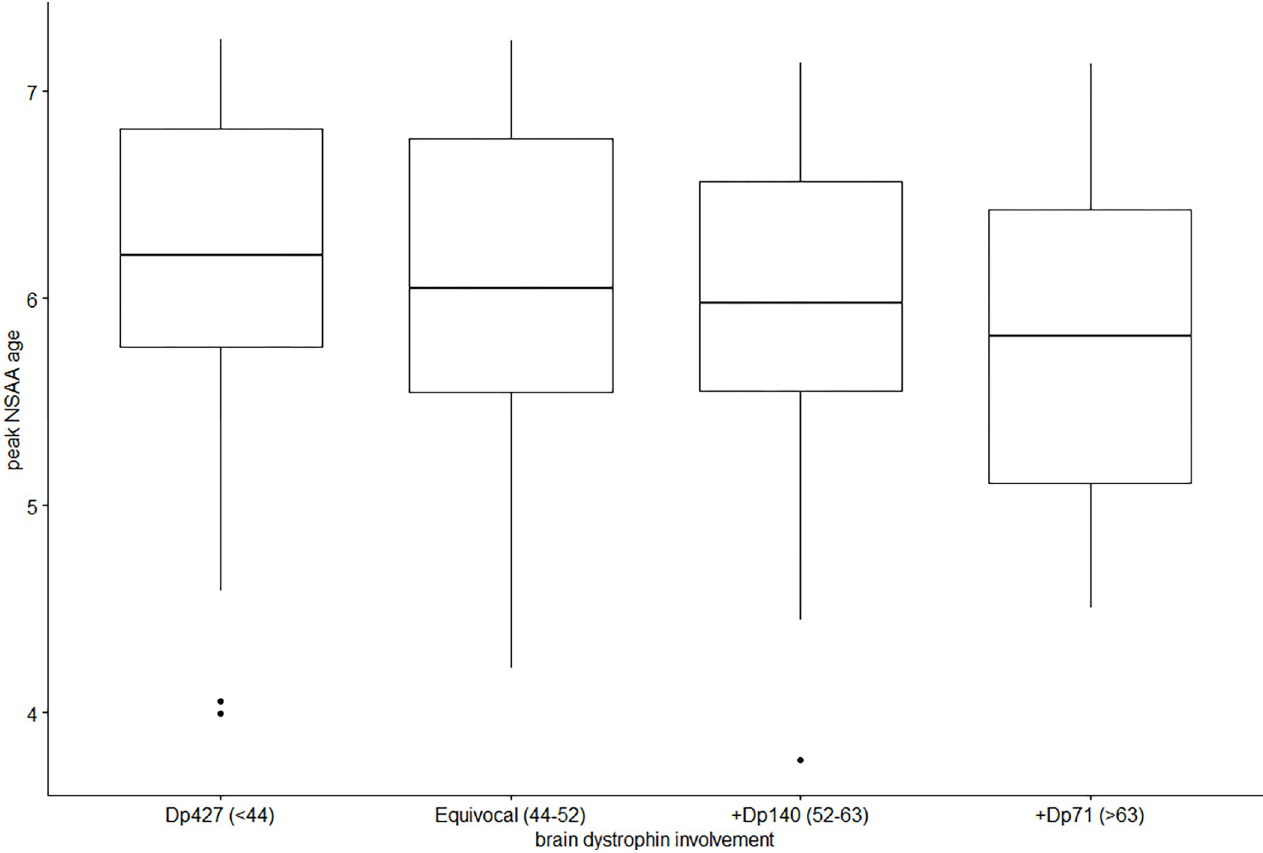
Fig 2. Age at maximum NSAA value and brain dystrophin involvement. Key to figure: Thick horizontal line = median value, box edges = 1 st and 3 rd quartile.